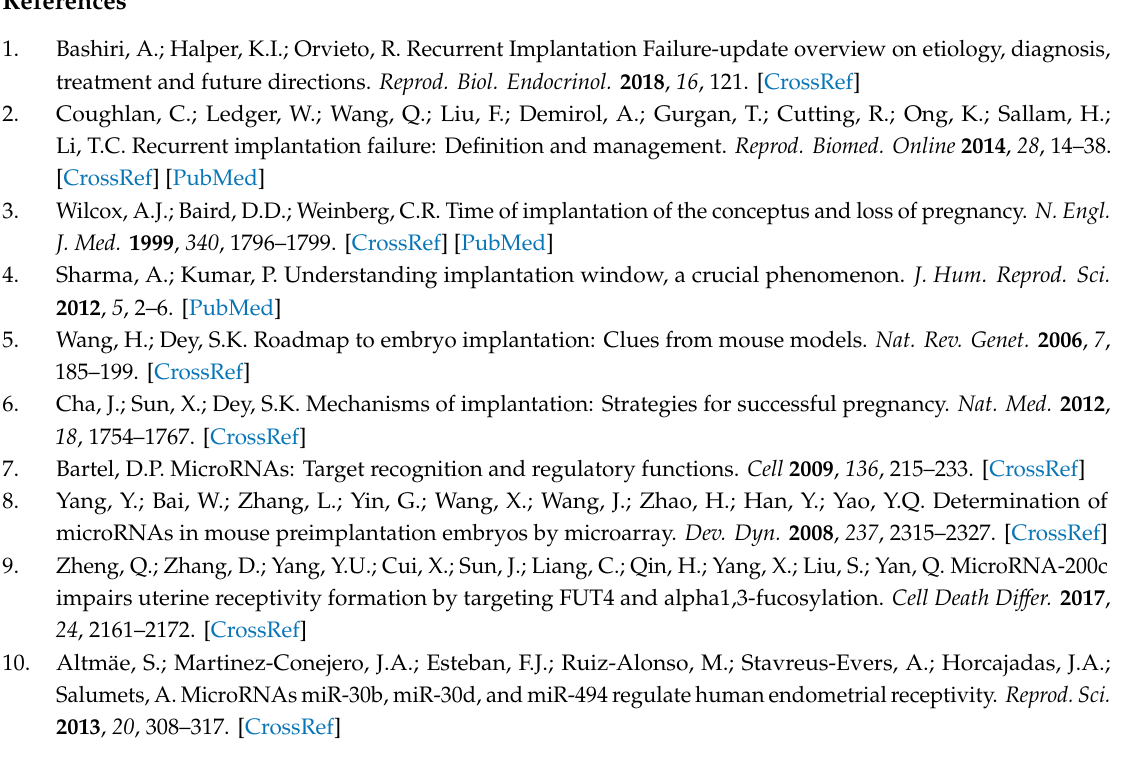
Figure S1: Small extracellular vesicles (sEVs) were secreted by endometrium during implantation. (a) SEM images shown the morphology of mouse endometrial surface on D2, D4, and D5 of pregnancy. Red arrows show the vesicles on the surface of endometrial epithelium similar to sEVs. Bar, 1200 × : 30 µ m, 10,000 × : 3 µ m. Electron microscopic images of sEVs in endometrium on D4 (b) and D5 (c). Red box indicated sEVs, Table S1: Detailed results of top 400 DEGs in each chip (GSE111974, GSE103465, GSE26787, and GSE92324), Table S2: The detail information of the top28 predicted miRNAs in each database, Table S3: The specific expression data of GAS1 and